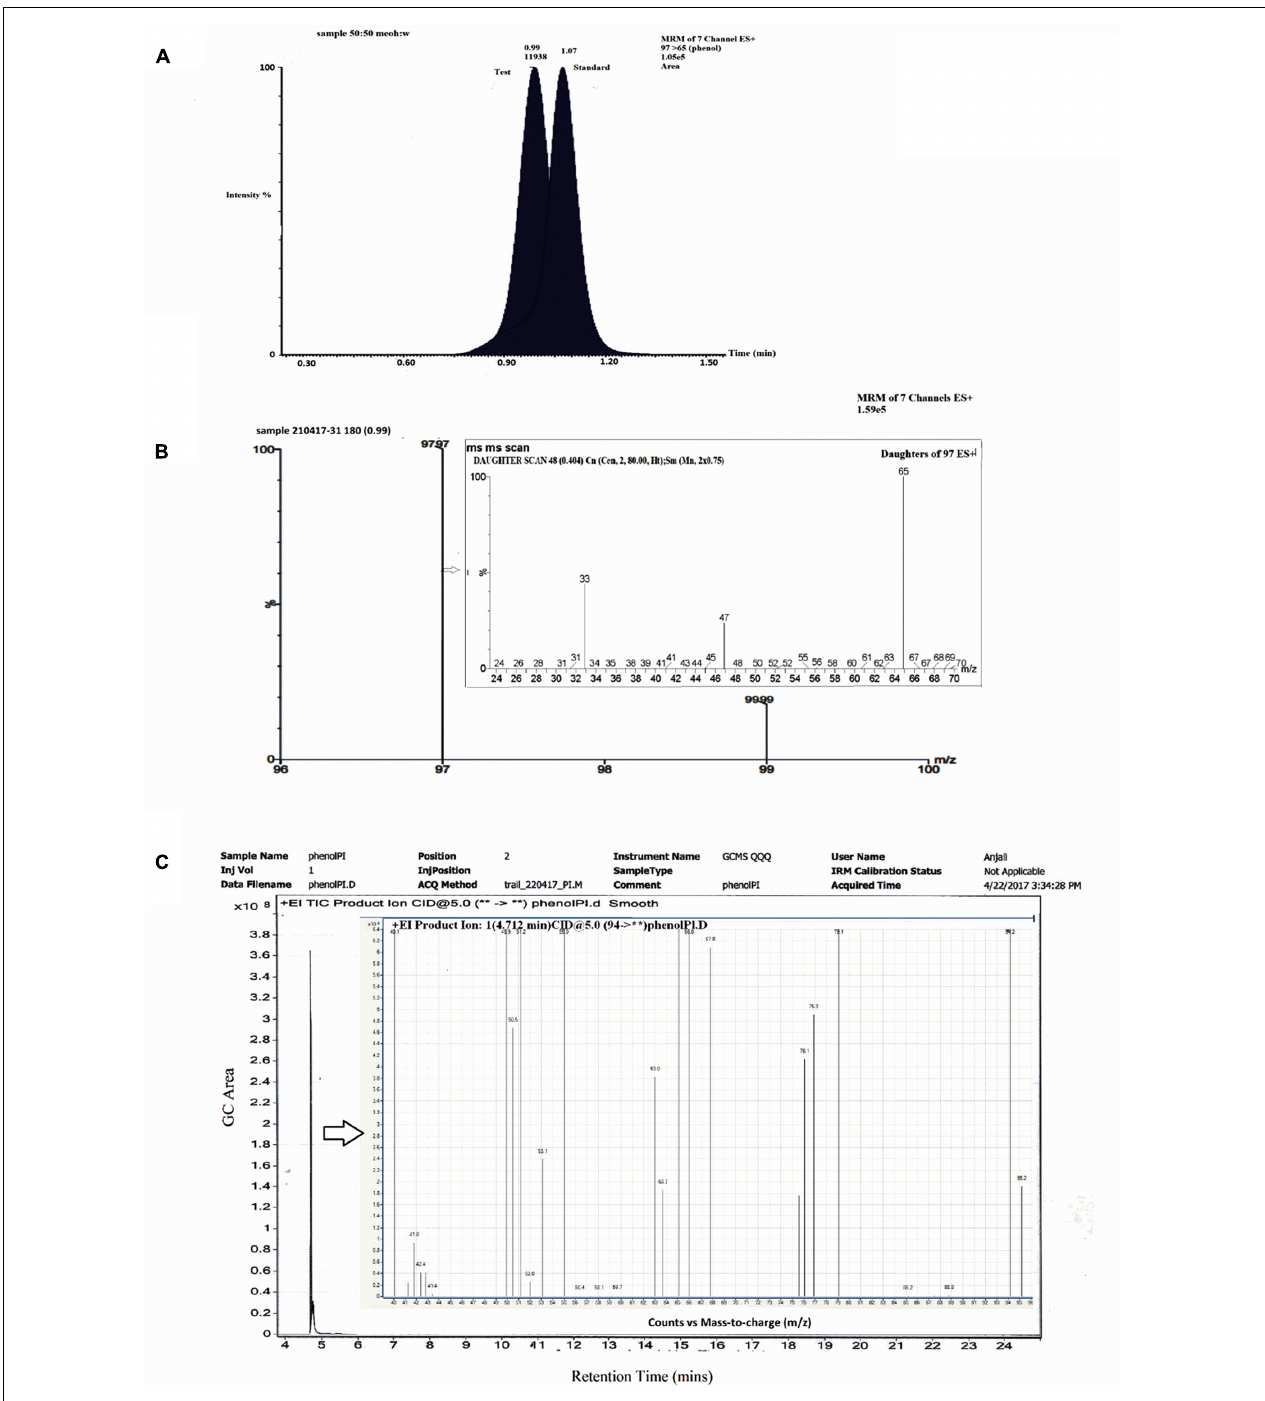
FIGURE 5 | LCMS and GC–MS analysis of labeled water experiments. (A) Chromatographic profile of standard phenol and test sample. (B) MRM spectra of test sample showing two fragments at m/z 97 and 99. (B) Inset: MSMS spectra of test m/z 97. (C) GC profile of test sample showing a single peak at Rt 4.712 min. (C) Inset: Mass spectra of peak at 4.712